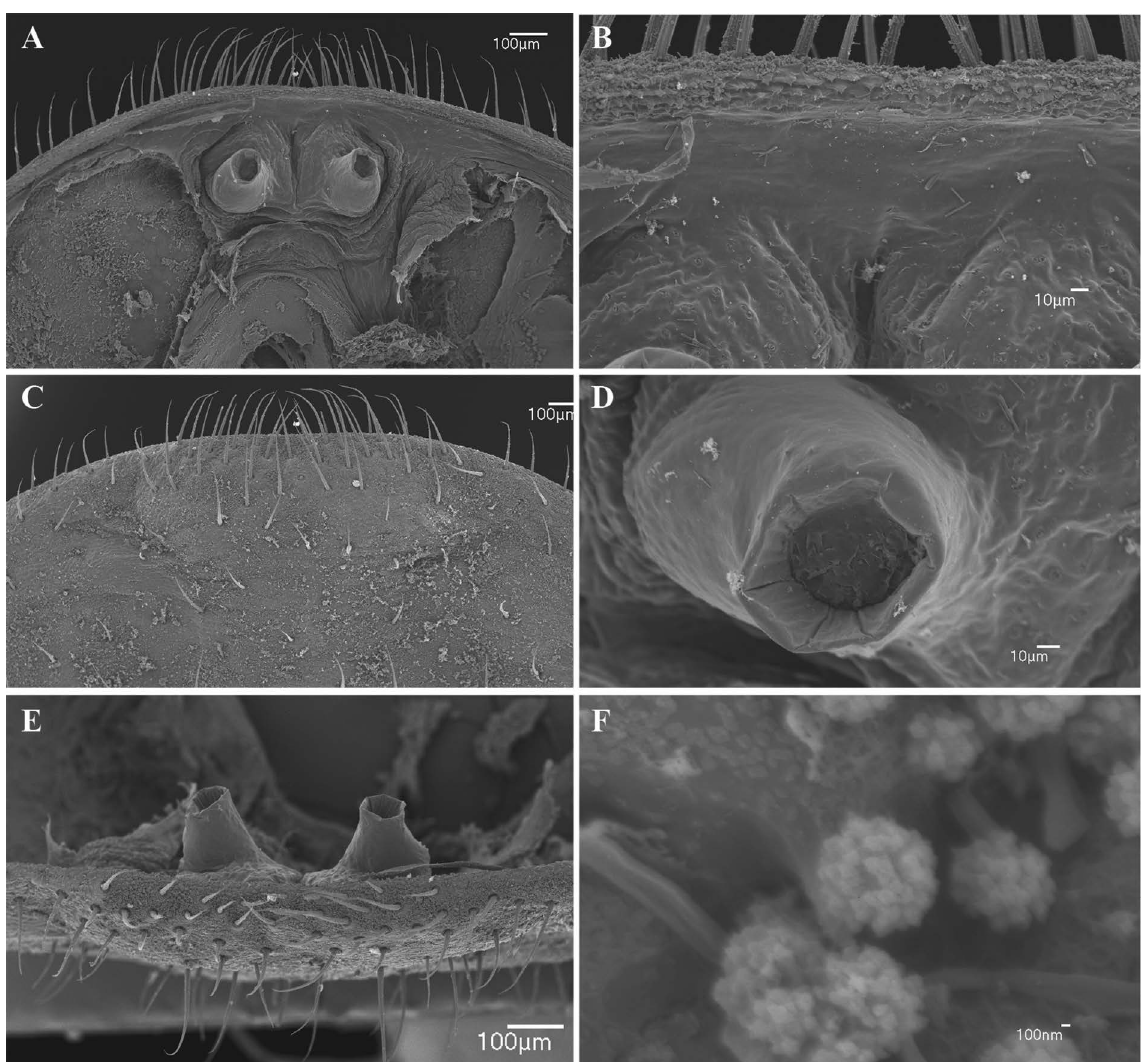
Fig. 72. Charinus puri sp. nov. (MNRJ 9223), female gonopod and genital operculum. A . Sucker-like gonopod, dorsal view. B . Genital operculum, ventral view. C . Gonopods, posterior view. D . Posterior margin of genital operculum, ventral view. F .